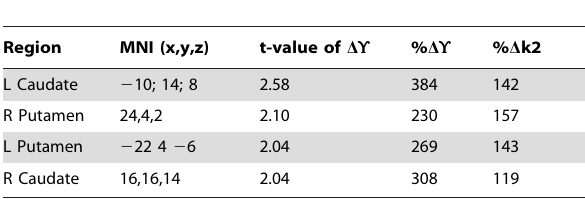
Table 1. The rate of ligand displacement increased significantly after task initiation (Incongruent condition) in four striatal areas.